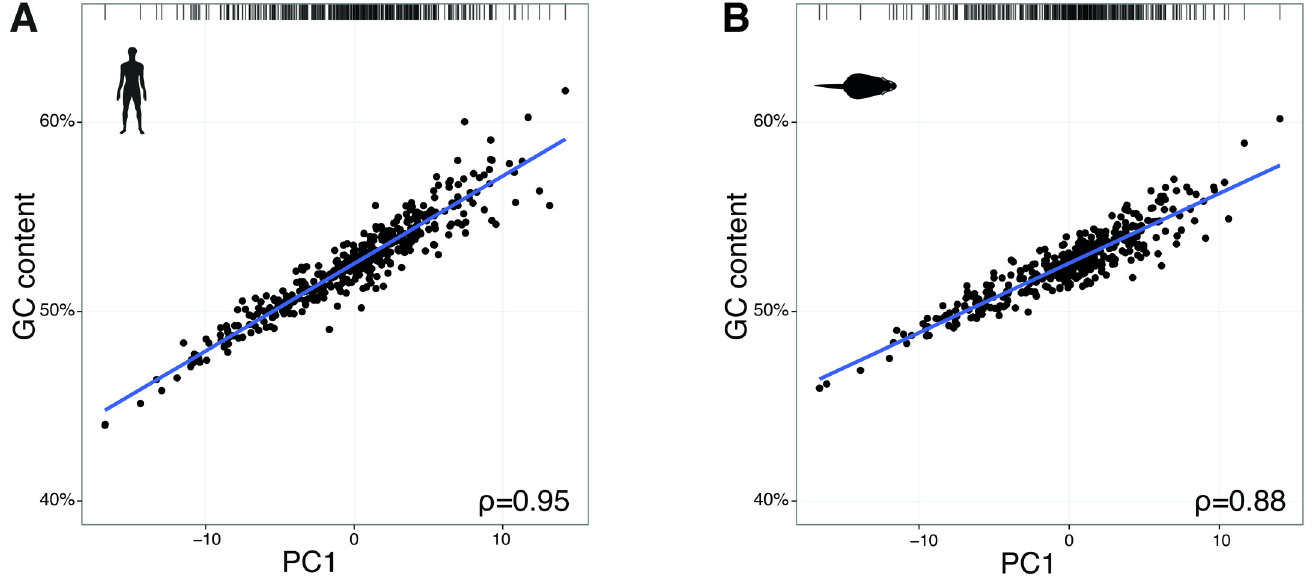
Fig 5. Translational efficiency correlates with transcriptomic GC content. The first principal component (PC) of genomic codon usage per Gene Ontology (GO) term (Fig 4A) of adult ( A ) human and ( B ) mouse liver (indicated by bar at the top) is plotted (x-axis) against the GC content for each gene set. Spearman ’ s rank correlation coefficients ( ρ ) are